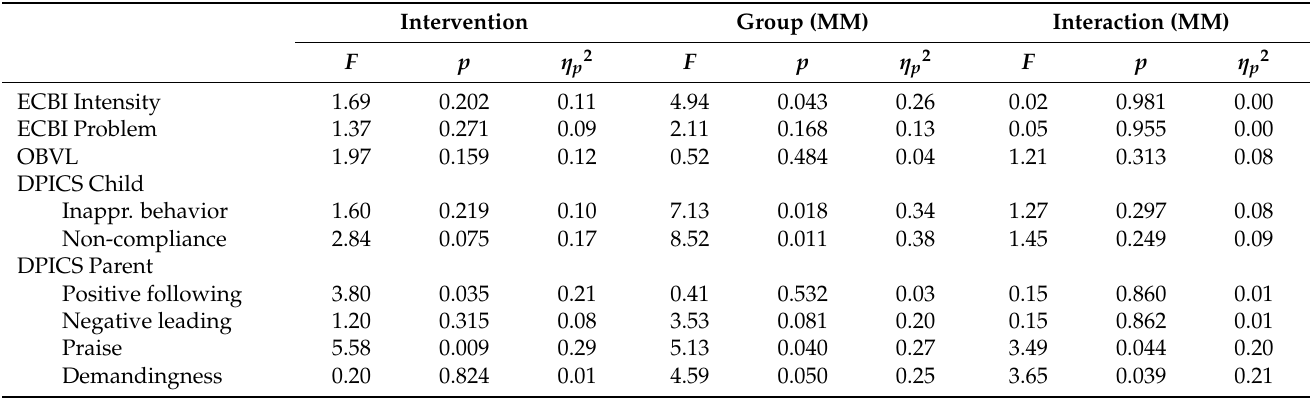
Table A3. Sensitivity analyses PCIT-Home repeated measures ANOVA results ( F -values, p ,